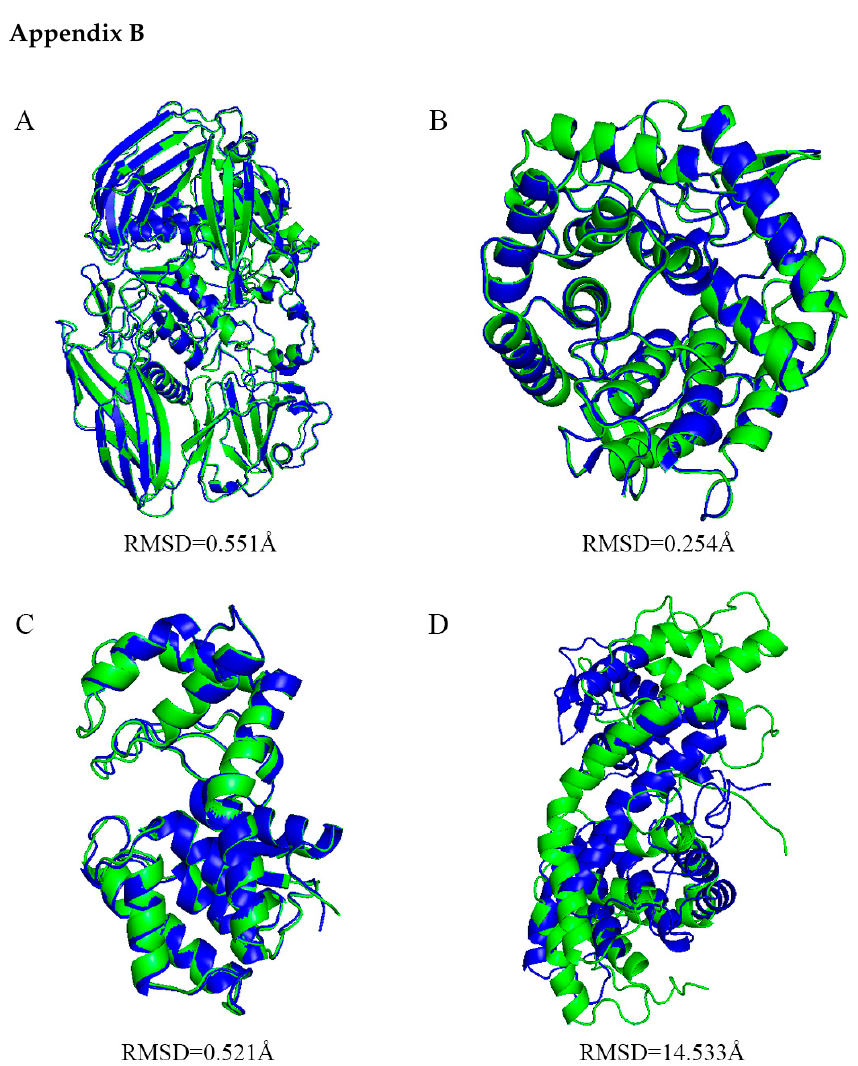
Figure A1. Predicted structures of four chitosanases. ( A–D ) show the results of aligning the predicted structure of the chitosanase from GH2(ID: 2x05), GH8(ID: 5xd0), GH46(ID: 4olt) and GH80(ID: 5b4s) to the experimental structure respectively.